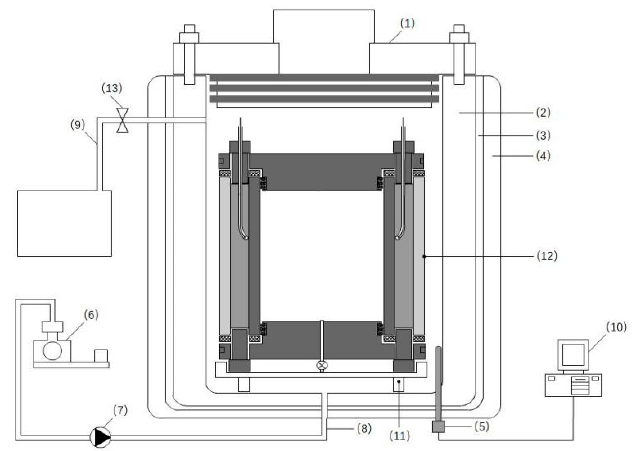
Figure 2. Casing/cement sheath/formation seal integrity evaluation device.